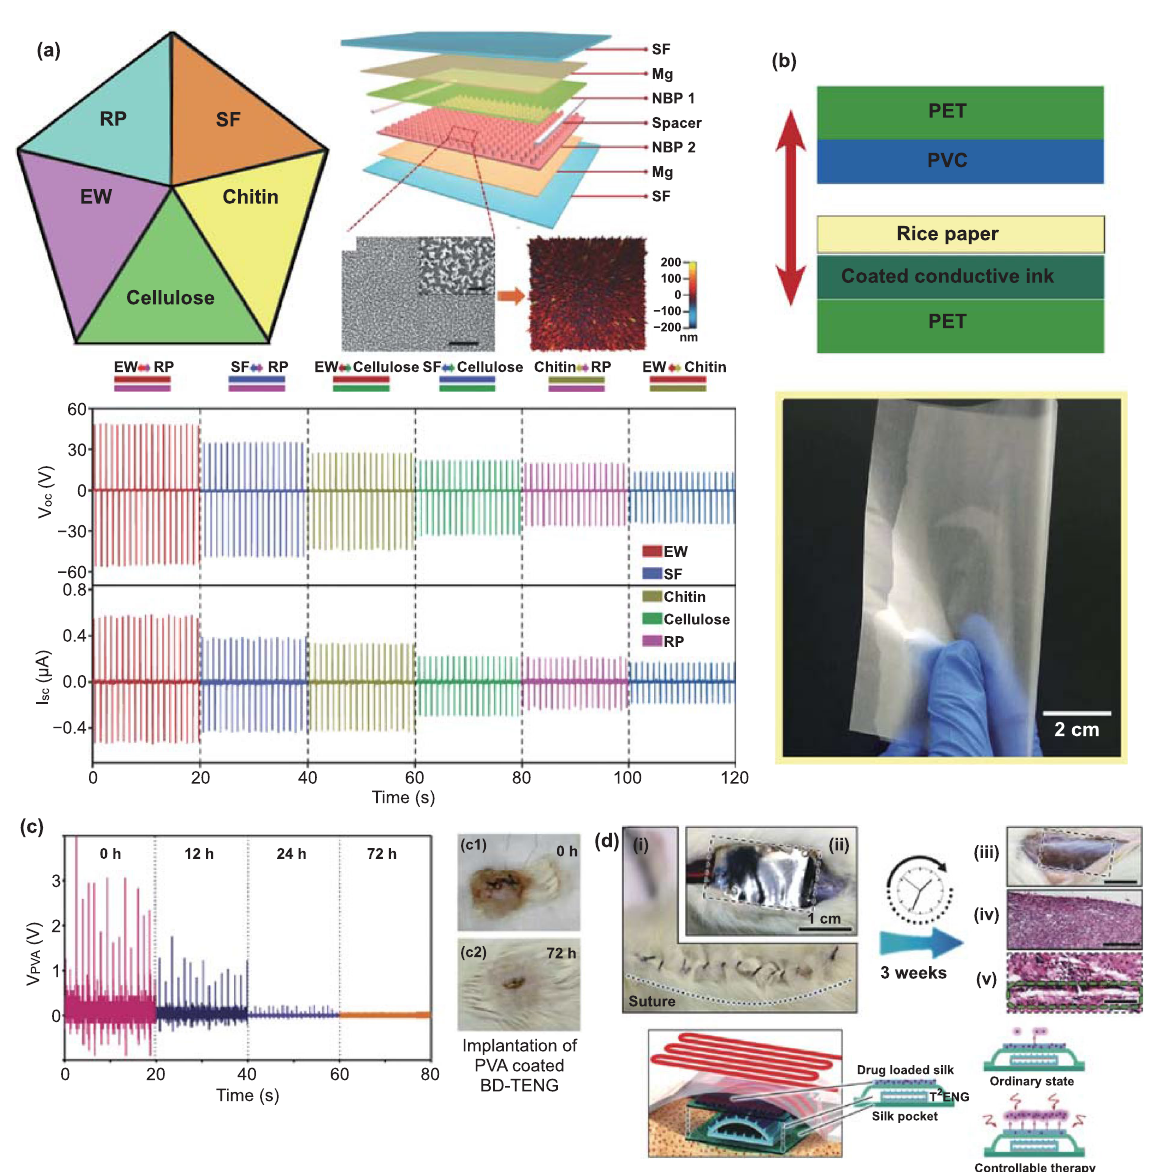
Fig. 4 a NBPs obtained from wide raw material sources and structure diagram of a typical BN‑TENG device: scanning electron microscopy (SEM) and atomic force microscopy (AFM) images of nanostructure on the surface of NBP film. Lower and upper scale bars: 5 and 1 µm. Reprinted with permission from Ref. [89]. Copyright (2018) Wiley‑VCH Verlag GmbH & Co. KGaA, Weinheim. b Photograph of the rice paper and scheme of the TENG: PET, PVC, transparent conductive electrode, and rice paper. Reprinted with permission from Ref. [90].